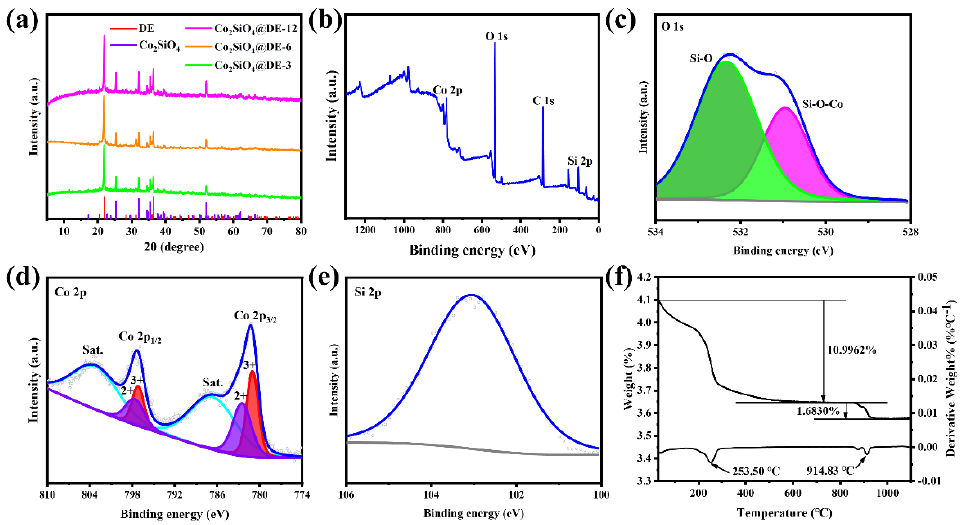
Figure 2. The XRD patterns ( a ) of Co 2 SiO 4 @DE-3, Co 2 SiO 4 @DE-6, and Co 2 SiO 4 @DE-12. The XPS ( b - e ) of Co 2 SiO 4 @DE-6: ( b ) full spectrum, ( c ) O 1s, ( d ) Co 2p, and ( e ) Si 2p. The TGA ( f ) of Co-precur-